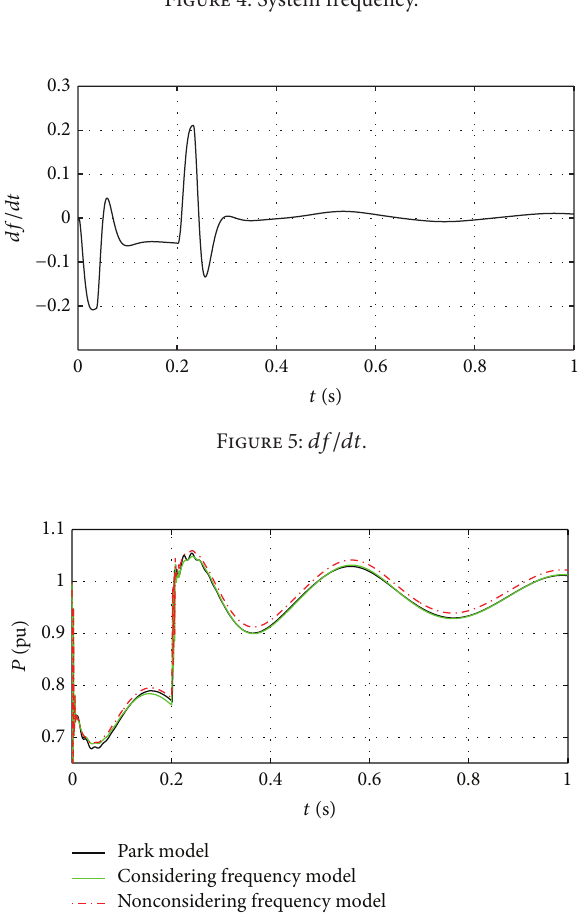
Figure 6: The active power of induction motor.